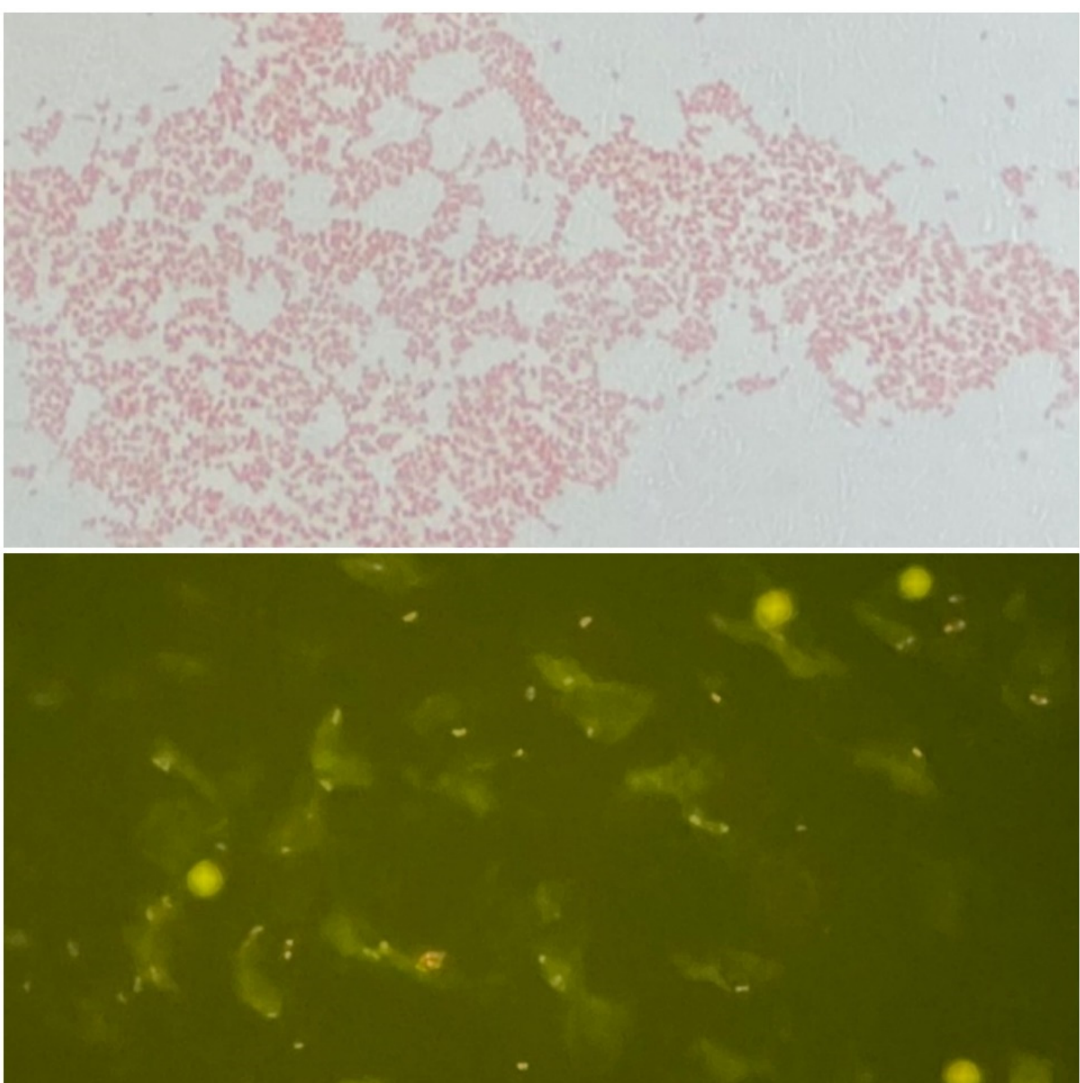
Figure 3. Gram stain ( top ) and acridine orange fluorescence microscopy ( bottom ) of bacteria isolated from blood cultures. Organisms appear as small, faintly-staining Gram-negative coccobacilli on a Gram stain, and as brightly fluorescent coccobacilli with the acridine orange stain.